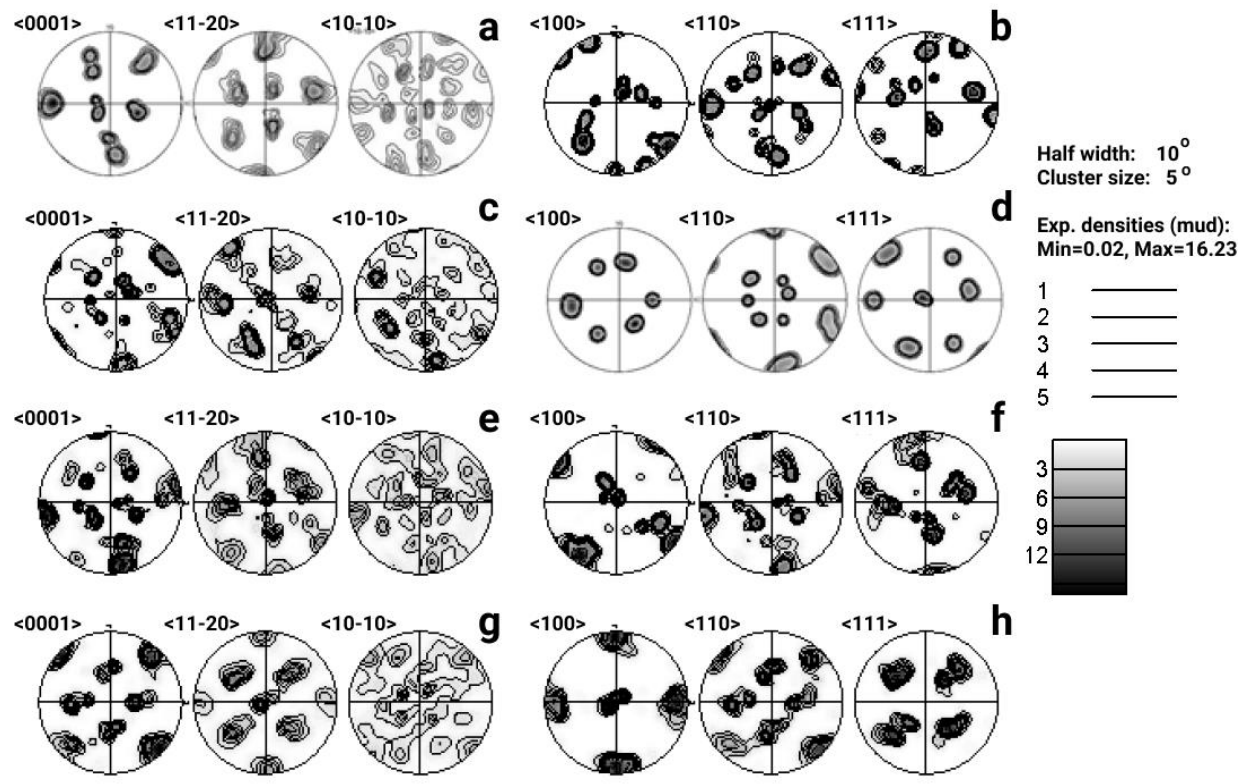
Figure 6. Pole figures <0001>, <11-20>, and <10-10> for α-phase (left column) and <100>, <110>, and <111> for β-phase (right column): ( a , b ) S1; ( c , d ) S2; ( e , f ) S3; ( g , h ) S4.